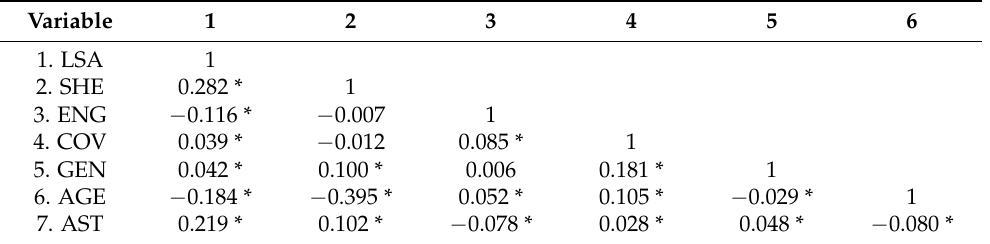
Table 3. Correlation matrix ( n = 3879).